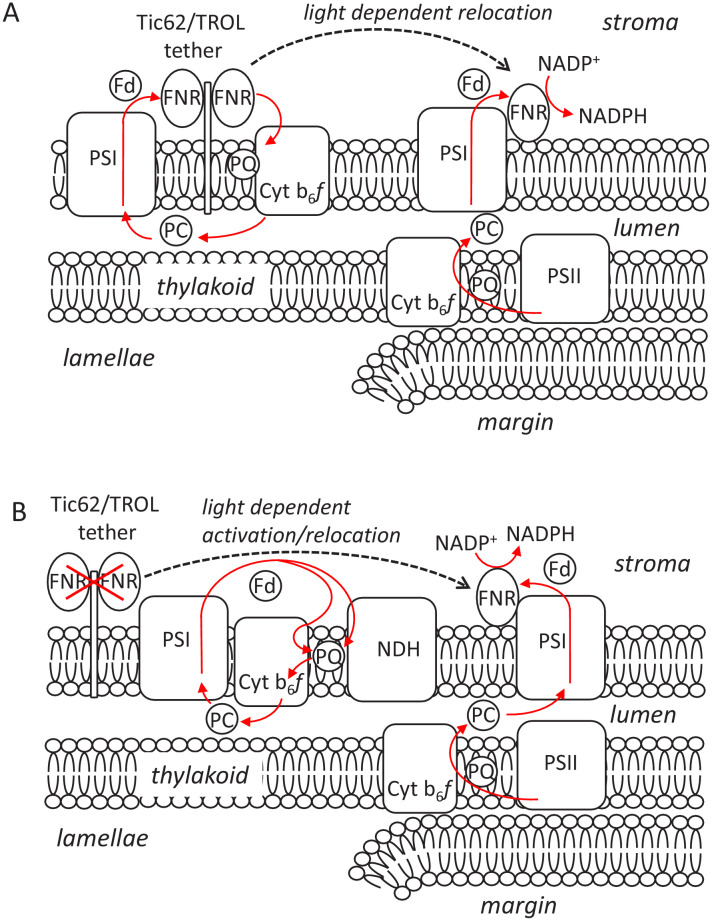
Two models describing potential mechanisms that could explain the impact of FNR interactions on photosynthetic electron transport during the dark to light transition.Models are based on data presented in this work that indicate (i) FNR is overwhelmingly membrane bound irrespective of interaction with the Tic62/TROL tethers (Figures 1 and 3); (ii) Strong FNR:Tic62/TROL association is required for the transient CEF seen on dark to light transition (Figure 5); (iii) Fast and slow (10–15 s) components of NADP+ reduction are seen at the onset of light, and the slow component is attenuated without FNR:Tic62/TROL tether interactions (Figure 4); (iv) there is a tendency for FNR accumulation at the margins during the light (Figure 6). Model A, Active role in CEF for the FNR:tether complex. Tight binding of FNR to Tic62/TROL during the dark sequesters some of the enzyme on the stromal lamellae, favouring increased CEF at the onset of light (possibly involving pgr5/pgrL1 and/or interaction with the Cyt b6f). As proton pumping drives ∆pH formation, FNR:tether interactions weaken, and a proportion of this enzyme relocates to PSI at the margins, increasing the rate of NADPH formation. Model B, Default CEF due to FNR deactivation on tether interaction. Binding of some FNR to the Tic62/TROL tethers inactivates the enzyme, driving CEF by default, either through the Cyt b6f or the NDH complex. Weakening of these associations during the light releases a proportion of this enzyme, activating it. Some of this FNR relocates to the margin region, increasing the rate of NADP+ reduction. In both models significant amounts of weakly bound FNR at the margins continue to conduct NADP+ reduction in both the dark and the light.